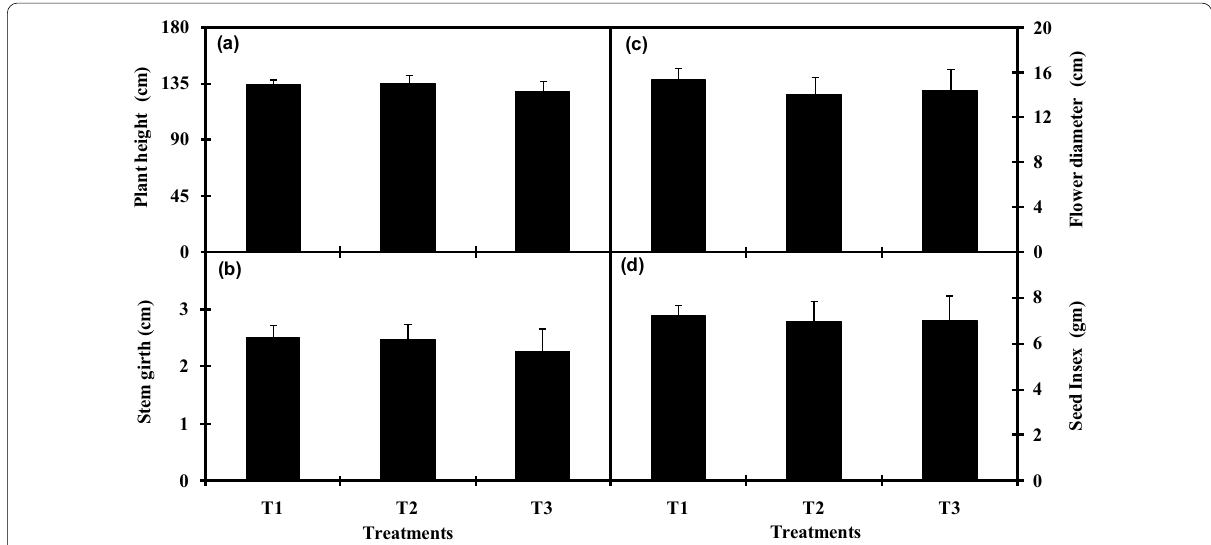
Fig. 3 Average plant height ( a ), stem girth ( b ), flower diameter ( c ) and seed Index ( d ) under different soil moisture regimes. T 1, T 2 and T 3 represent 30, 50 and 70% soil moisture depletion levels, respectively. The values are